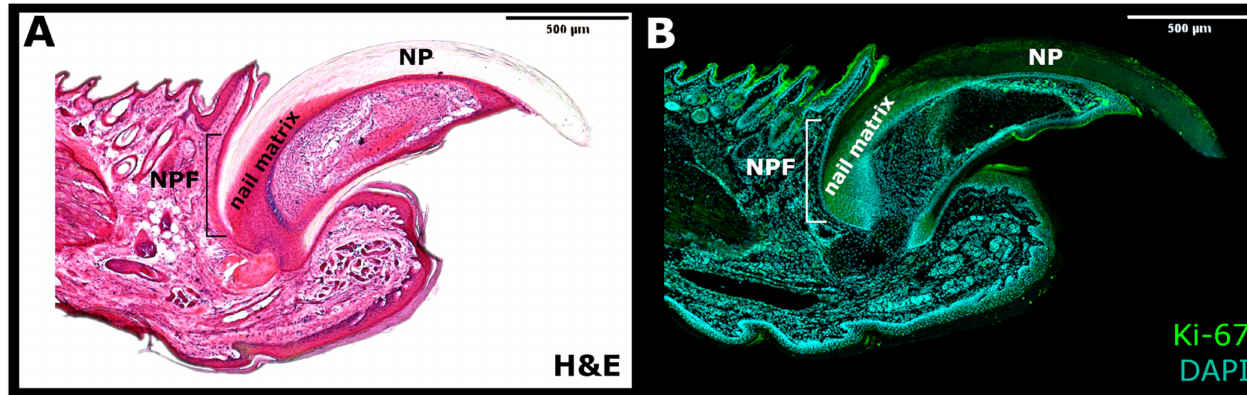
Figure 2. The side section of the nail mini-organ. ( A ) Haematoxylin and eosin (H&E) staining. ( B ) Immunofluorescence for Ki-67 marker of proliferation (Green) and DAPI (Blue). NPF—nail proximal fold; NP—nail